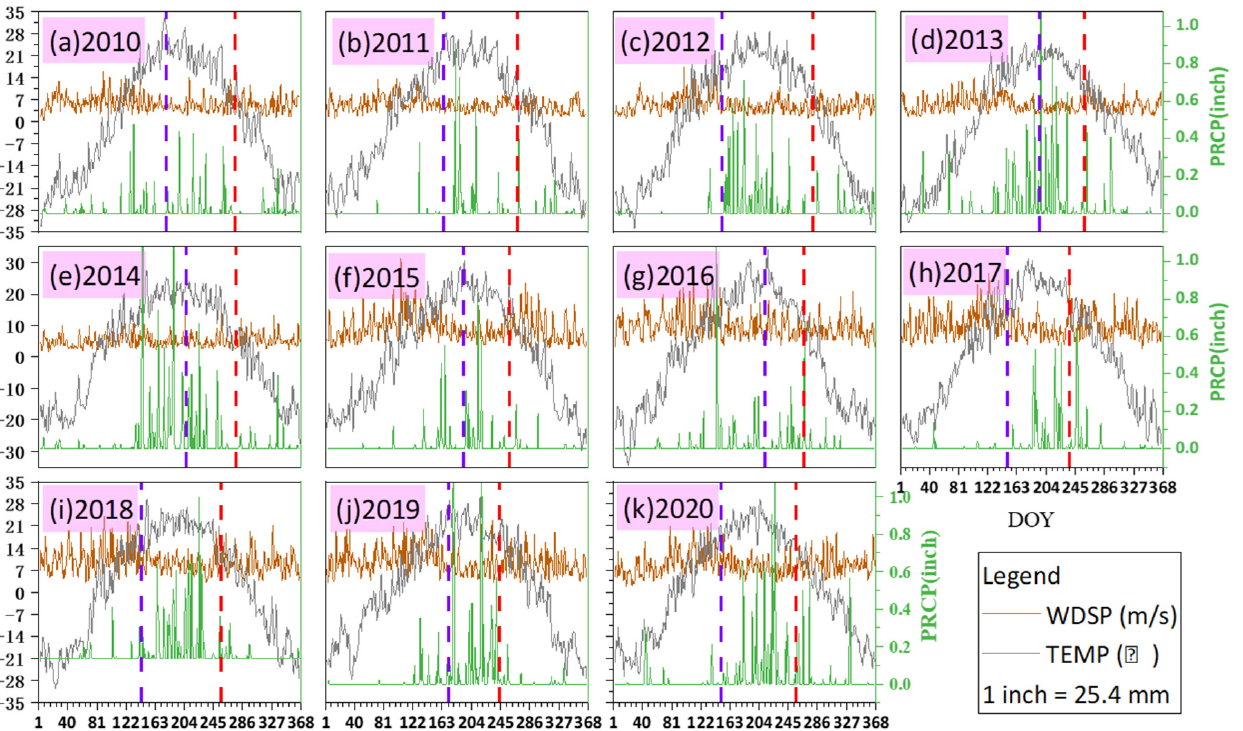
Figure 9. Parameters of climate factors in the Hulun Lake from 2010 to 2020. The blue and red dotted lines in each coordinate system represent the transparency inversion dates for summer and autumn of the corresponding year, respectively.